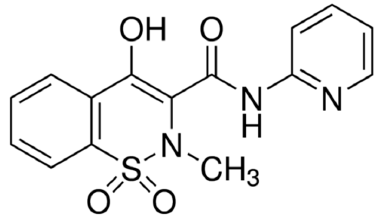
Figure 1. The structure of piroxicam (Px).